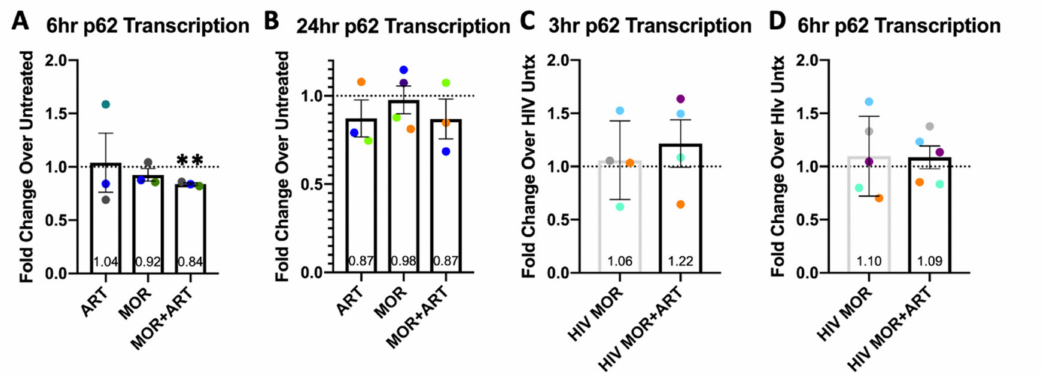
Figure 4. Measurements of p62/SQSTM1 transcription in uninfected and HIV-infected primary human macrophages. MDM were cultured, infected with HIV or not for 3–4 days, and left untreated (Untx) or treated with morphine and/or ART for 3, 6, or 24 h as indicated. RNA was isolated, reverse transcribed to cDNA, and RT-qPCR analysis was performed with 18S as the reference gene. ( A ) p62/SQSTM1 transcription in uninfected MDM at 6 h of treatment relative to control by 2 − ∆∆ Ct . ( B ) p62/SQSTM1 transcription in uninfected MDM at 24 h of treatment relative to control. ( C ) p62/SQSTM1 transcription in HIV-infected MDM at 3 h of treatment relative to infected control. ( D ) p62/SQSTM1 transcription in HIV-infected MDM at 6 h of treatment relative to infected control. n = 3–5 independent experiments with error bars representing SEM, ** p < 0.01 one-sample t